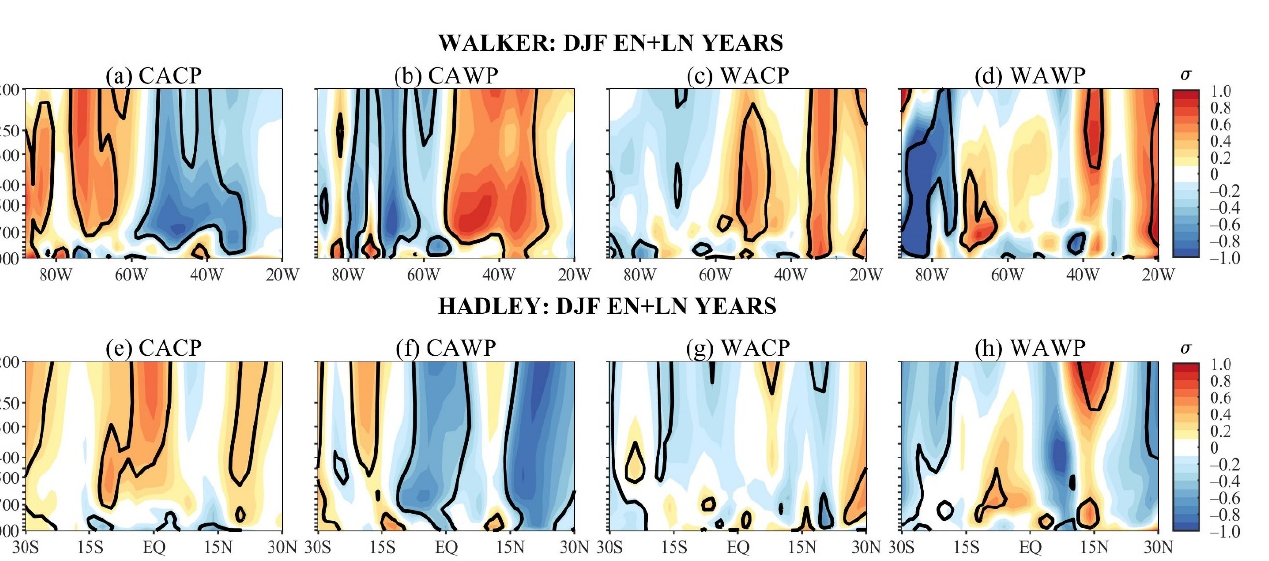
Figure 7. Austral summer longitude vertical cross-section of the WVEL anomaly composites of EN + LN during the: ( a ) CACP, ( b ) CAWP, ( c ) WACP, and ( d ) WAWP mean states; and latitude vertical cross-section of the HVEL anomaly composites of EN + LN during the: ( e ) CACP, ( f ) CAWP, ( g ) WACP, and ( h ) WAWP mean states. Continuous contours encompass the significant anomalies at a 90% confidence level using the Student’s t -test. The symbol σ above the colour bar means standard deviation.